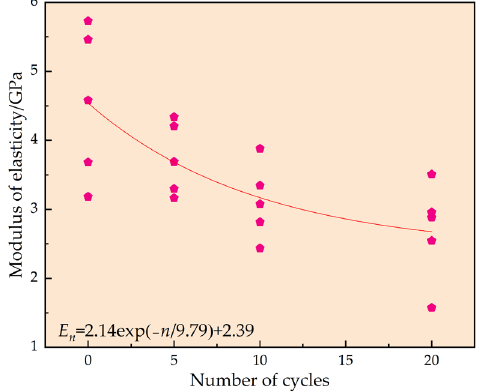
Figure 7. Modulus of elasticity of fracture–grouted rock specimens under different numbers of wet- ting–drying cycles and fitting. wetting–drying cycles and